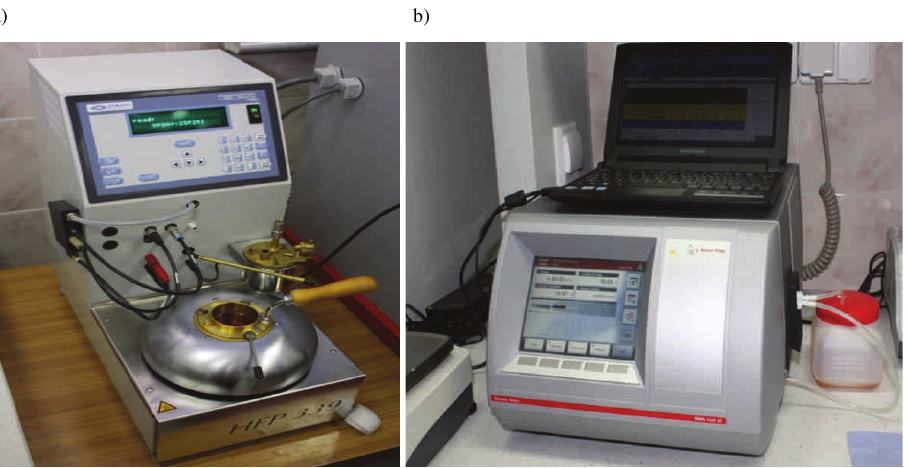
Fig. 3. Research devices: (a) HFP 339 Pensky-Martens Flash Point Analyzer; (b) DMA 4500 M Accurate Density